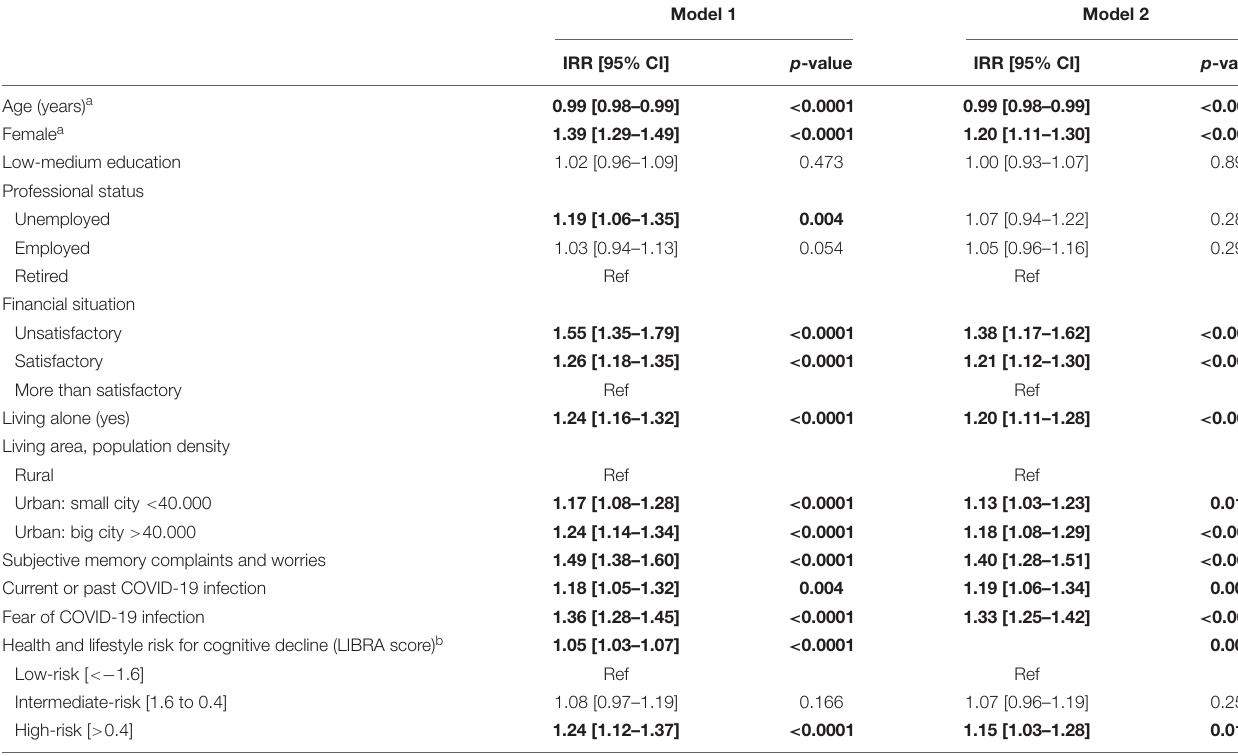
TABLE 2 | Univariable and multivariable analyses of the association of participant characteristics with multiple detrimental lifestyle